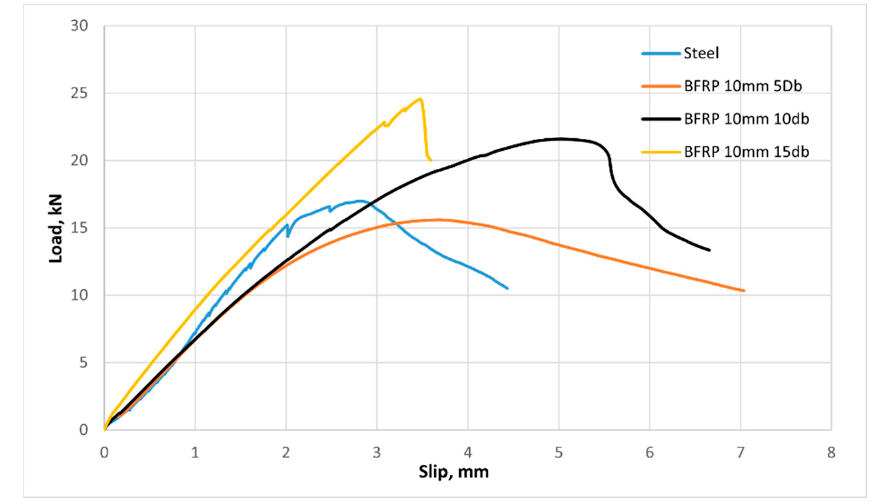
Figure 22 . Load–slip relationship of the 10-mm BFRP and steel bars . The peak loads of the 10-mm steel bars and 10-mm BFRP bars are in a similar range, confirming the suitability of BFRP bars as reinforcement materials, as can be seen from the comparison plot in Figure 22. This indicates that the 10-mm bars of BFRP give similar pull-out performance when compared to steel bars of same diameter, showing promising potential for the use of Basalt FRP as an alternative for the conventional steel reinforcing bar. Furthermore, the results of specimens with steel bars were similar for self-compacting geopolymer concrete (SCGC), geopolymer concrete, and conventional concrete of 40 MPa strength [53–56]. The outlier values in some of the specimens in this series of experiments were due to the shutting down of the UTM midway through the experiment. This study provides promising results for the use of basalt bars as a reinforcement alternative to con- ventional steel bars. Moreover, the self-compacting geopolymer concrete, with its advan- tageous features—including strength, flowability, lack of need for vibration, and ambient curing properties—would make the BFRP-reinforced specimens more efficient to use eas- ily in real life scenarios [1,2,7,53–56]. The current experimental investigation finds that while studying the causes of bond behaviour, it is important to consider other parameters, such as fibre volume in each of the bundles for basalt or any other kind of FRP bars, as these may influence the bond behaviour. The reinforcement sectional area, surface roughness of the rebar, bar diameter,